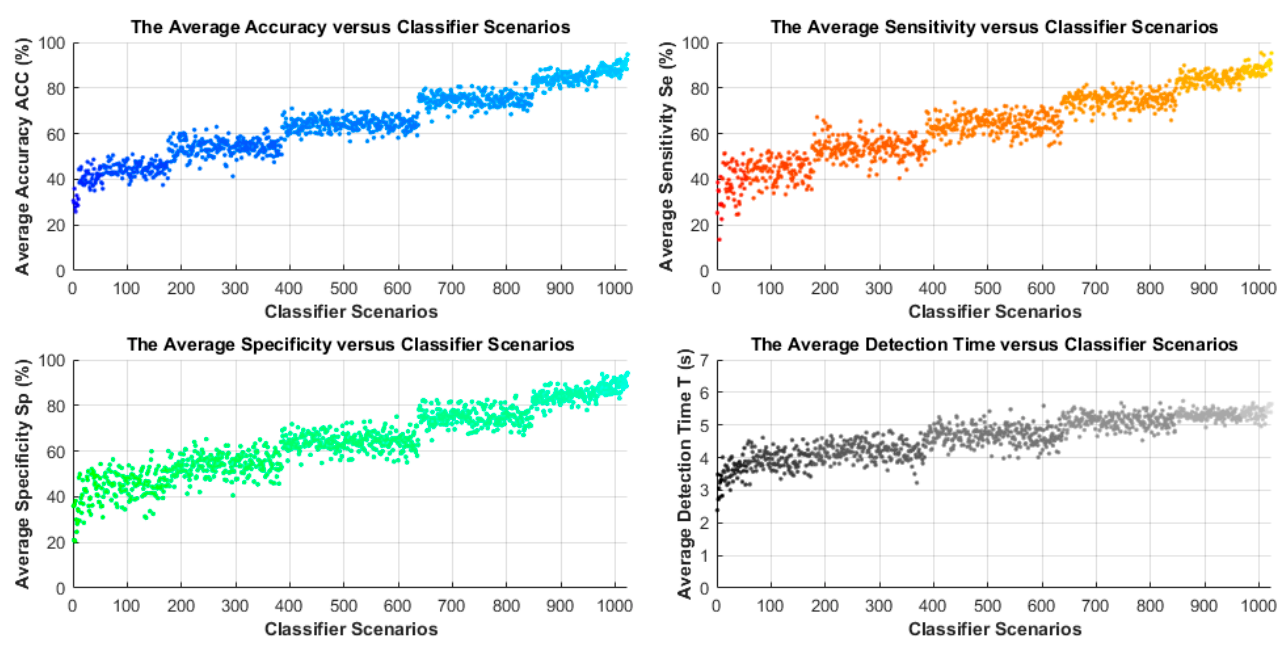
Figure 5. Performance evaluation of various classifier scenarios of MC-MLI.